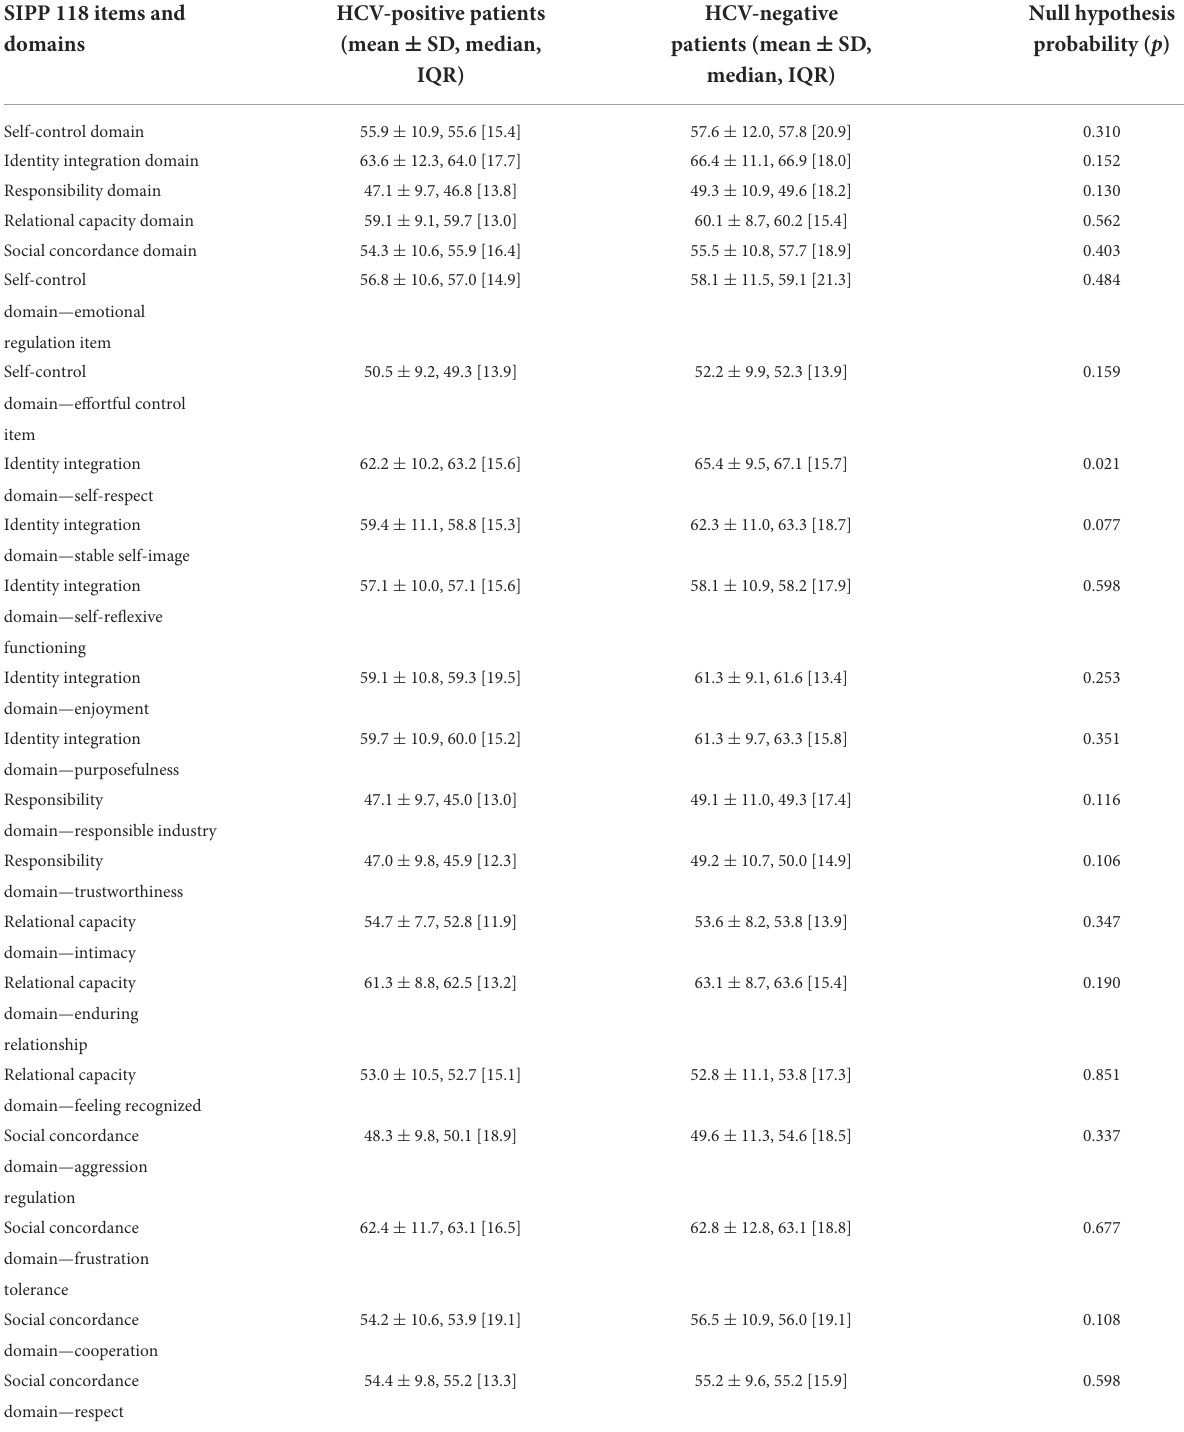
TABLE 2 Values of SIPP 118 items and domains according to HCV infection